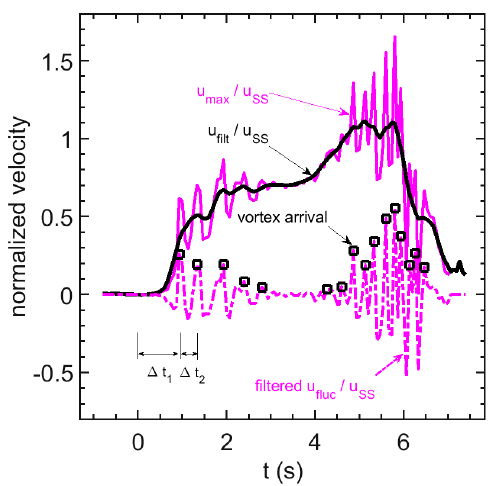
Figure 3. Glottal jet velocity waveforms, showing five realizations each, for lowest and highest reduced frequencies studied. ( a ) f* = 0.01, Re h = 6560. ( b ) f* = 0.06, Re h = 4120. Vortex motions are only partially phase-locked to vocal fold wall motions, giving rise to cycle-to-cycle variations in jet velocity, especially during glottal closure.